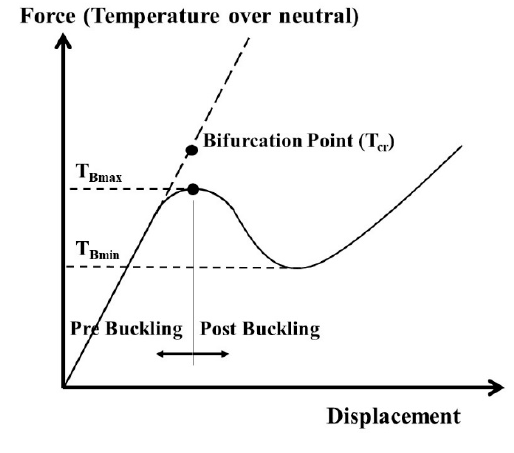
Figure 4. Buckling path.